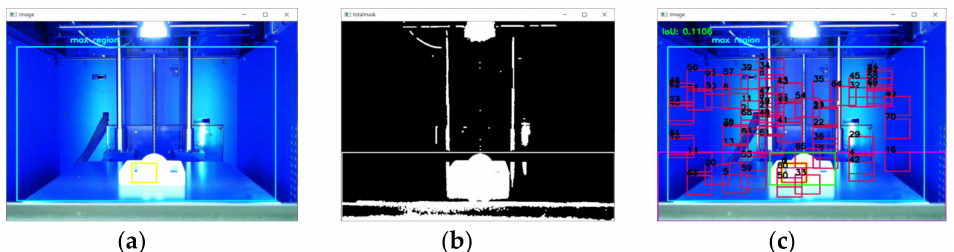
Figure 14. Test 3 product result of proposed algorithm: ( a ) reference ROI for auto color picking; ( b ) final mask binarization image after merge operation (random sampling ROI: 70); ( c ) Test 3 product result (random sampling ROI: